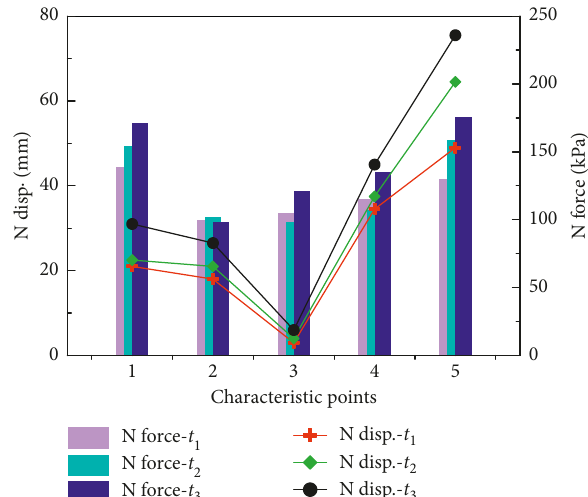
Figure 9: Normal deformation and force due to frost